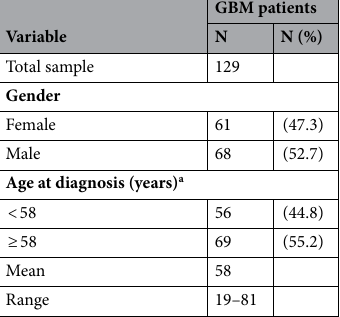
Table 1. General information for glioblastoma multiforme patients. GBM glioblastoma multiforme. a Data were missing in 4